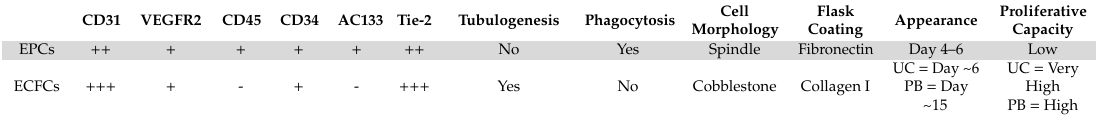
Table 1. Difference in the characteristics between endothelial progenitor cells (EPCs) and ECFCs.